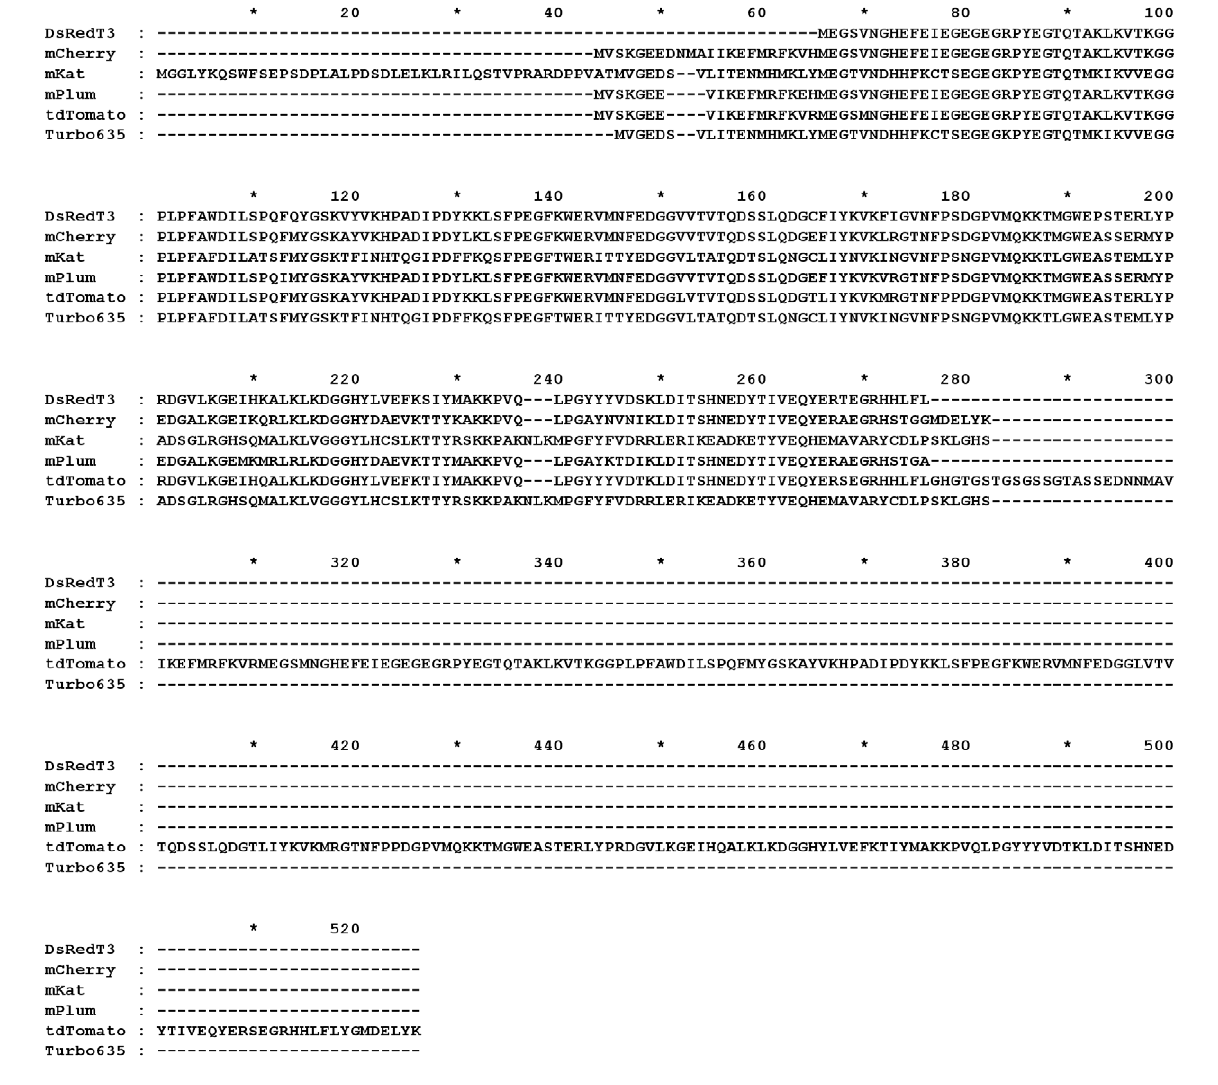
Figure 1. Amino-acid alignment of the far-red fluorescent proteins used in this studywithDsRed. mCherry, mPlum,mKat and Turbo635 are all expressed as monomers, tdTomato is expressed as a tandem dimer. Identical residues are marked with *, similar residues are marked with : and .